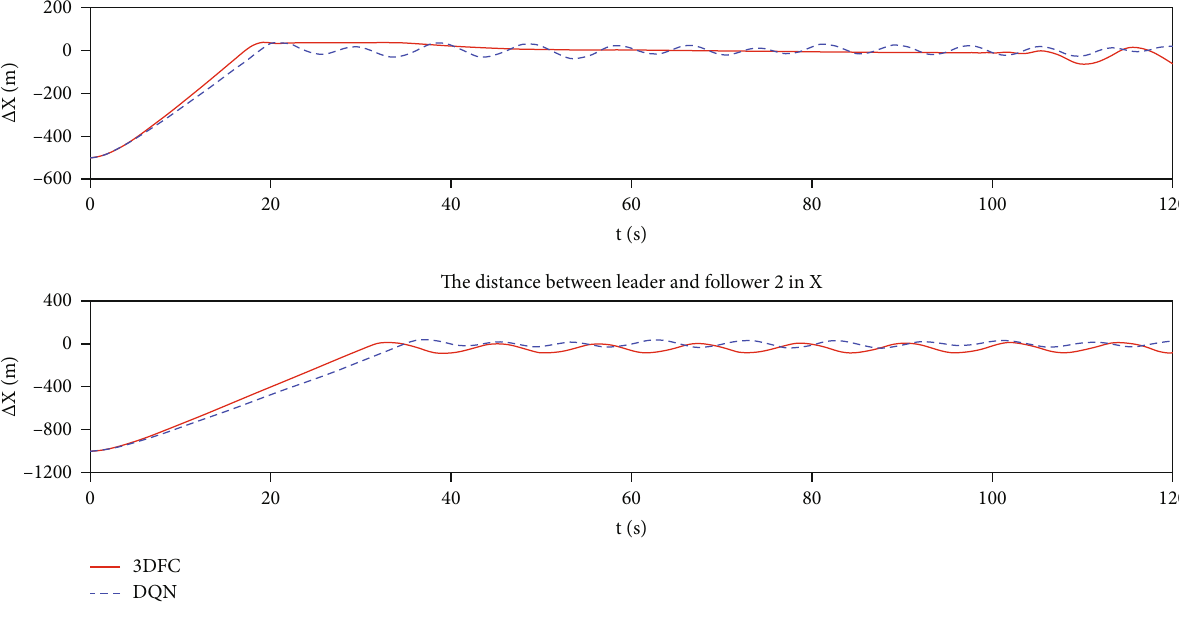
Figure 7: The relative distance Δ X between the leader and the